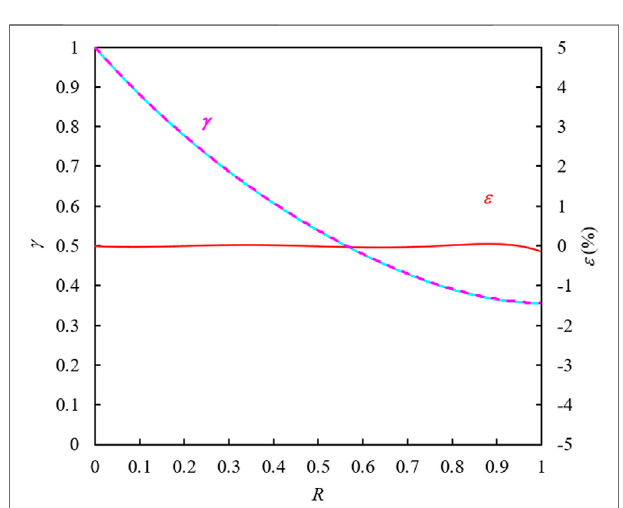
FIGURE 10 | λ and ε vs. R for the fi eld case.